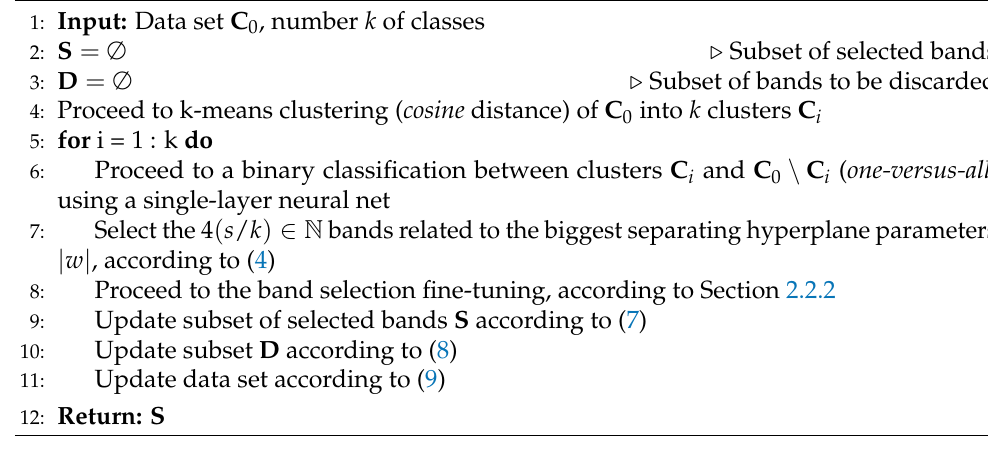
Algorithm 3 Proposed band selection